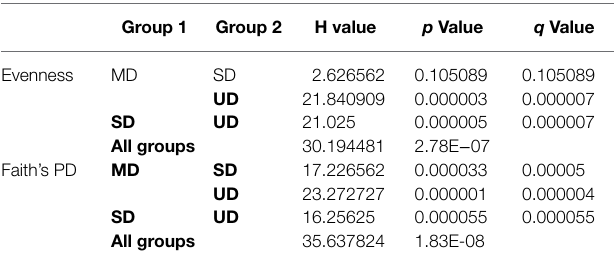
TABLE 1 | All groups and pairwise comparison of alpha diversity by Kruskal-